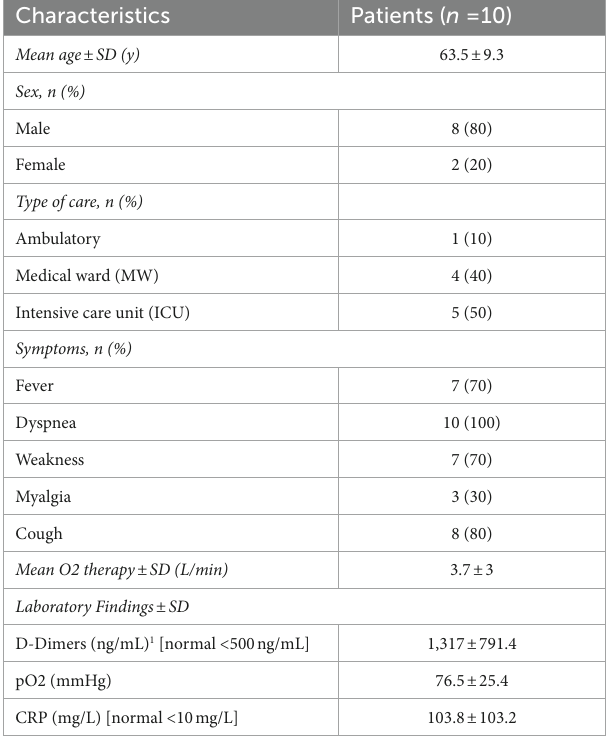
TABLE 1 Patient characteristics.